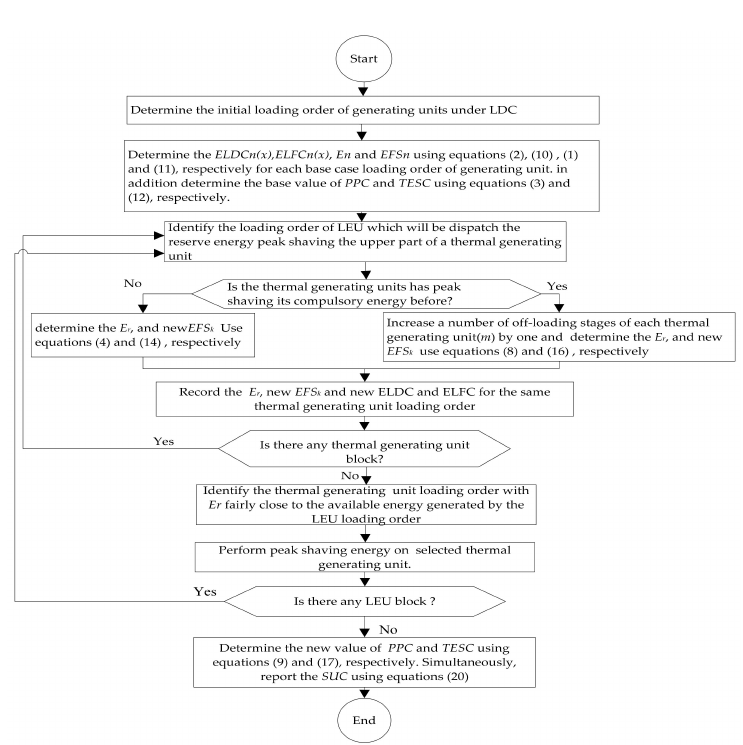
Figure 2. Flow chart of saving utility cost determination based on dispatch increment energy E r from several limited energy units (LEUs) using the probabilistic peak-shaving technique (PPS)